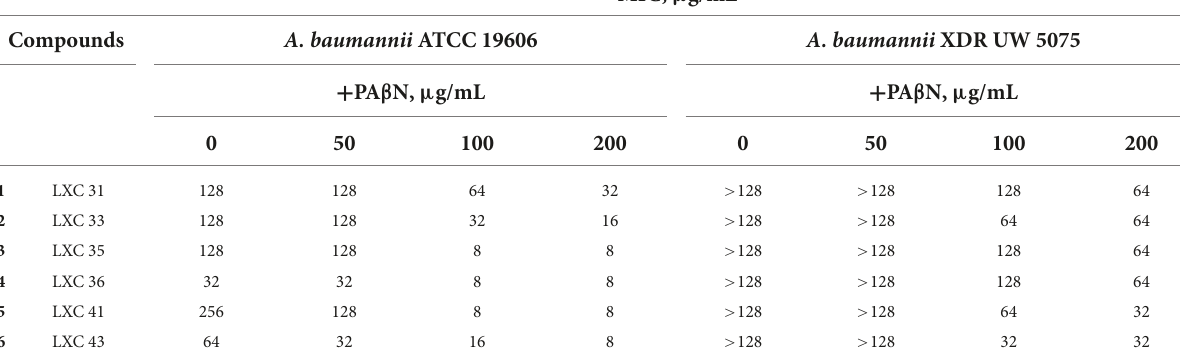
TABLE 2 MIC of the LXC compounds against A. baumannii ATCC 19606 and XDR UW 5075 in the absence or presence of PA β N.